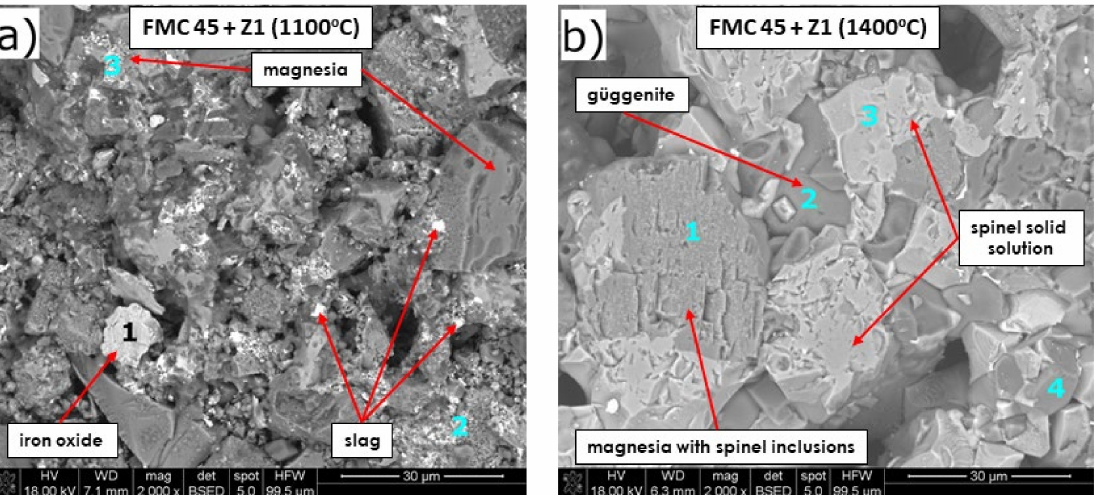
Figure 7. SEM images of magnesia–chromite co-clinker FMC 45 after pellet test at ( a ) 1100 ◦ C,